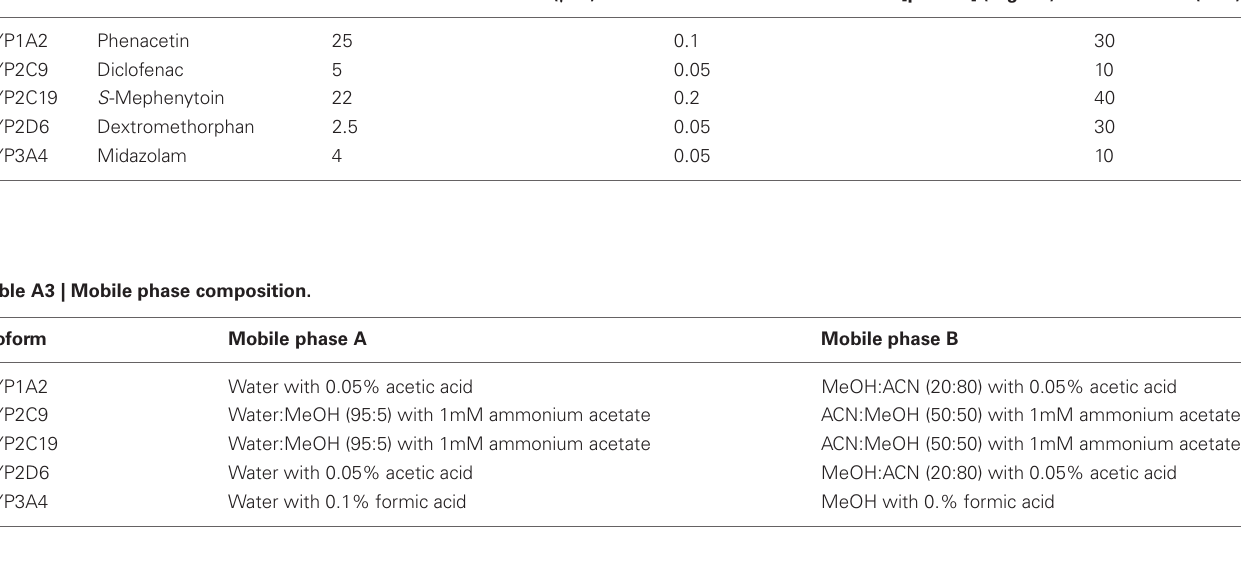
Table A2 | Incubation conditions used to evaluate the inhibitory effect of A-998679 on specific CYP isoforms. Isoform